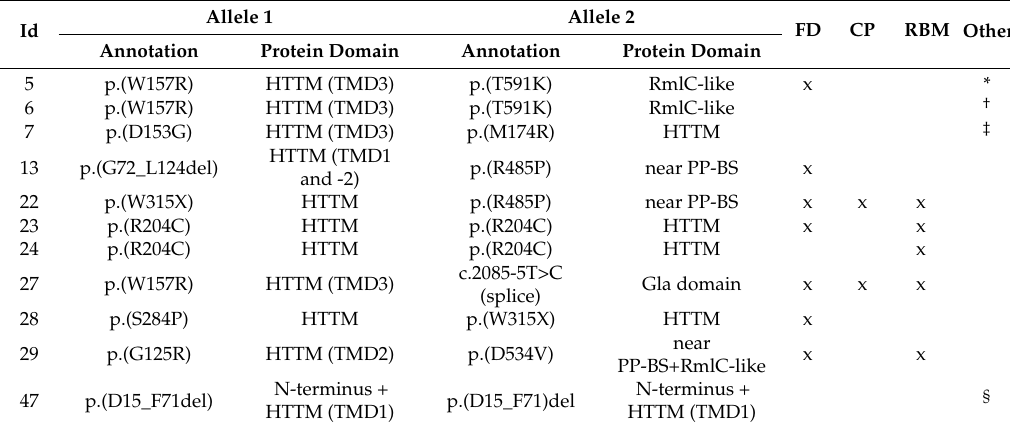
Table 7. Osseous involvement in patients with GGCX mutations. This table gives an overview of all patients in the analyzed cohort with osseous manifestations features. For each patient, the GGCX mutations on both alleles and the affected protein domain are stated (protein annotation). Further, a brief overview of the bone features is